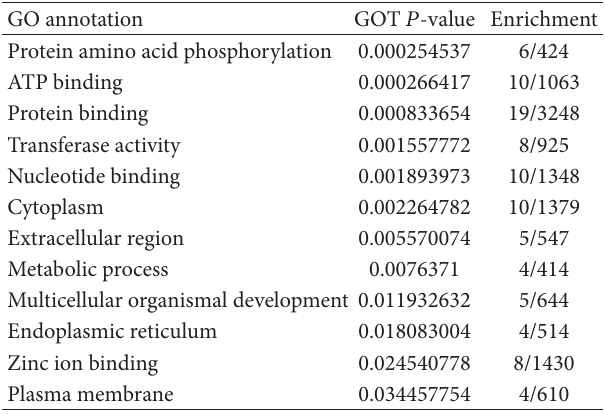
T 9: Overrepresented GO terms extracted from the union of 68 common genes either of BD patients or of SZ patients.